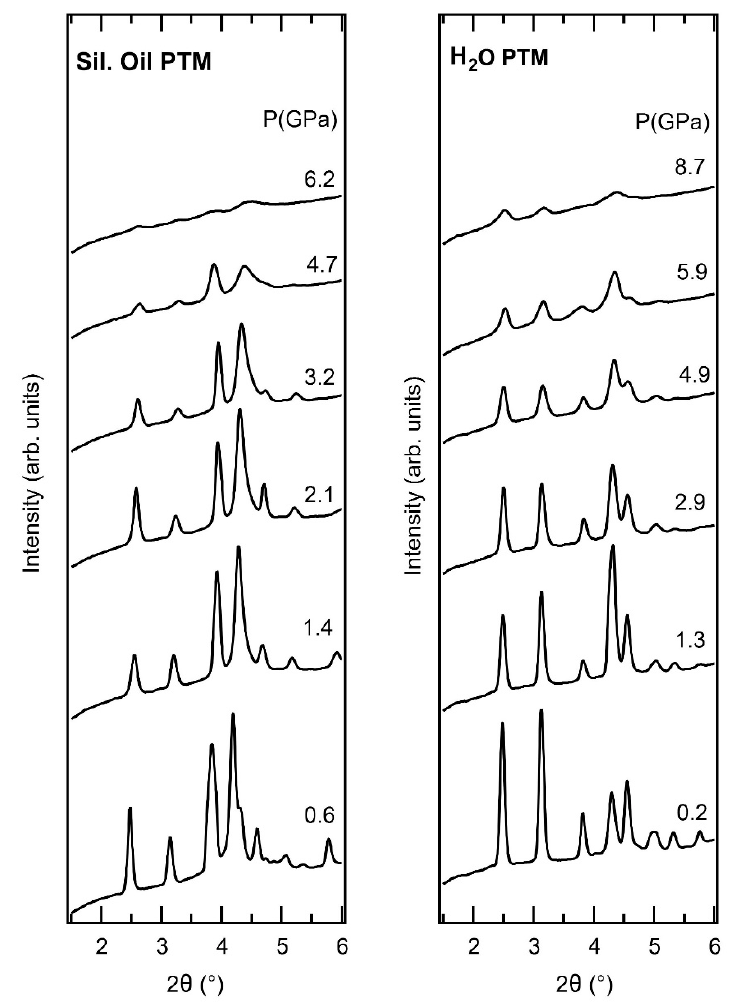
Figure A1. In situ powder synchrotron XRD patterns of AlPO 4 -17 • x H 2 O in silicone oil ( left ) and in H 2 O ( right ) at selected pressures.